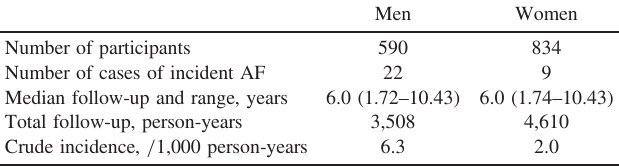
Table 1. Number of AF cases, median follow-up period and Table 2. LAD tertiles and AF risk factors of 1,424 participants: the crude incidence in 1,424 participants: the Suita study Suita study Men Women Number of participants 590